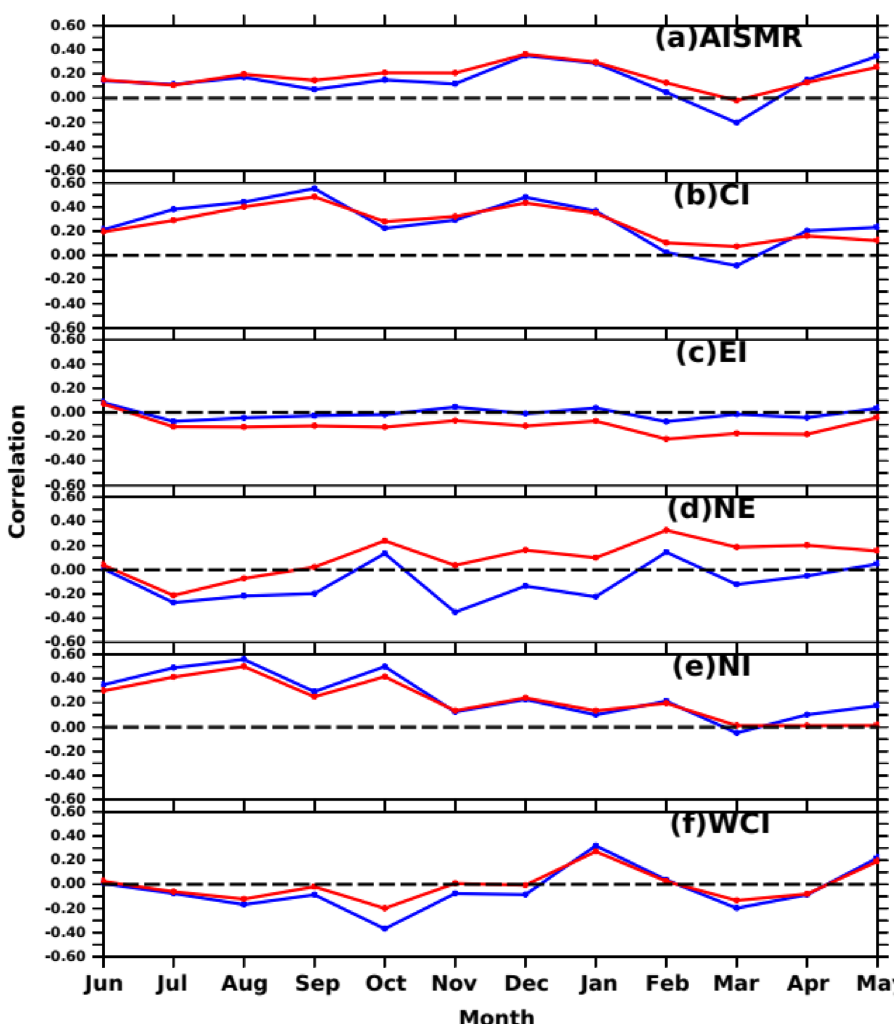
Figure 8. Time series of lagged correlation between detrended SSTA over SWIO and detrended regional rainfall (SAI) over the five homogeneous regions and entire Indian landmass before (red) and after (blue) removing ENSO effect. The figure is generated using PyFerret